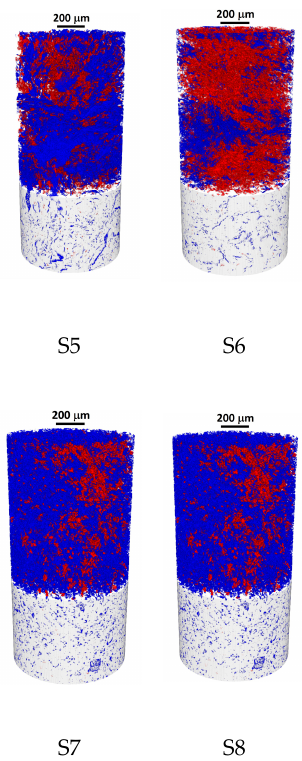
Figure 3. Characteristic micro-CT images of brick samples illustrating the quantitative differences reported in Table 3 (closed pores are marked in red, open pores in blue and the matrix is colored grey). Table 3. The percentage of open pores, the percentage of closed pores and the interconnection of pores.